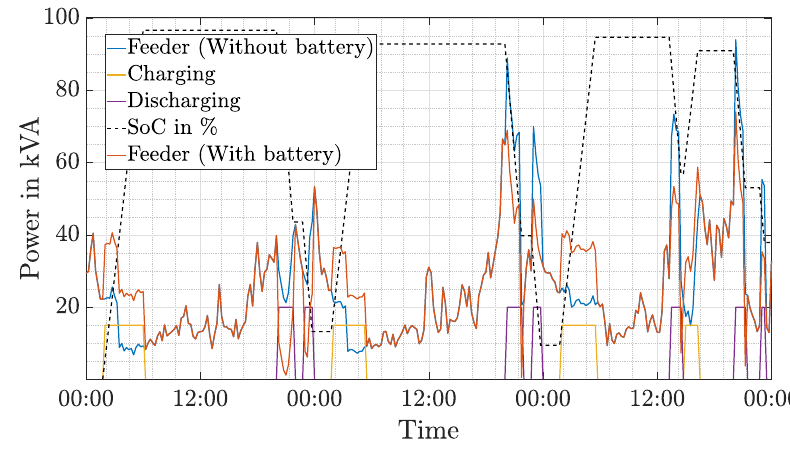
Figure 8. Exemplary course for the fixed schedule